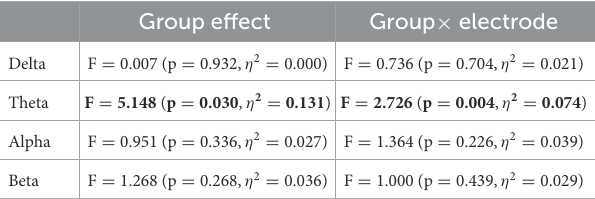
TABLE 5 The results of the repeated-measure analysis of covariance between the high- and low-cognitive function groups for the value of betweenness centrality, using age and educational history as